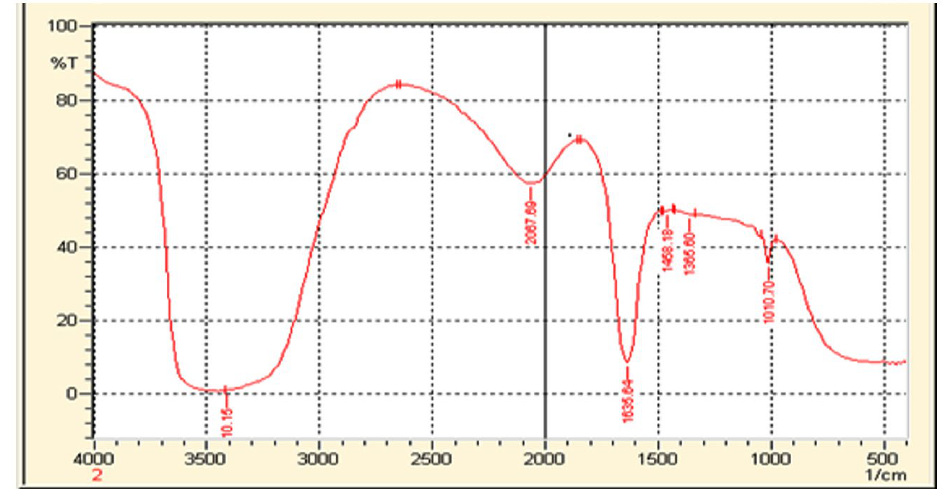
Fig. 2. FT-IR analysis of synthesized AuNPs from D. salicifolia crude